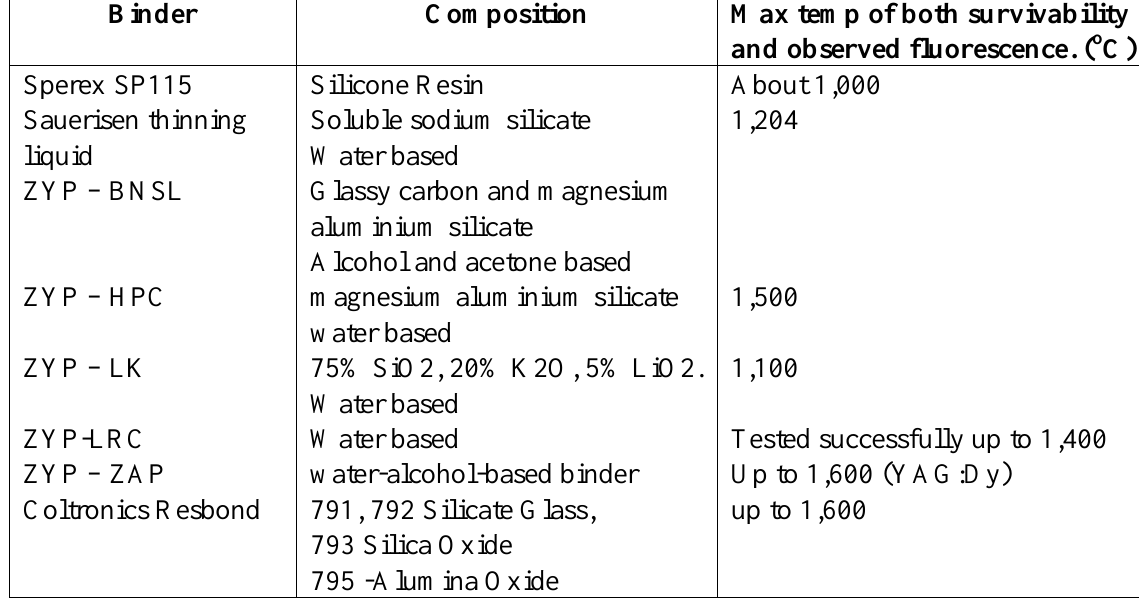
Table 7. Comparison of various high temperature chemical binders [59].